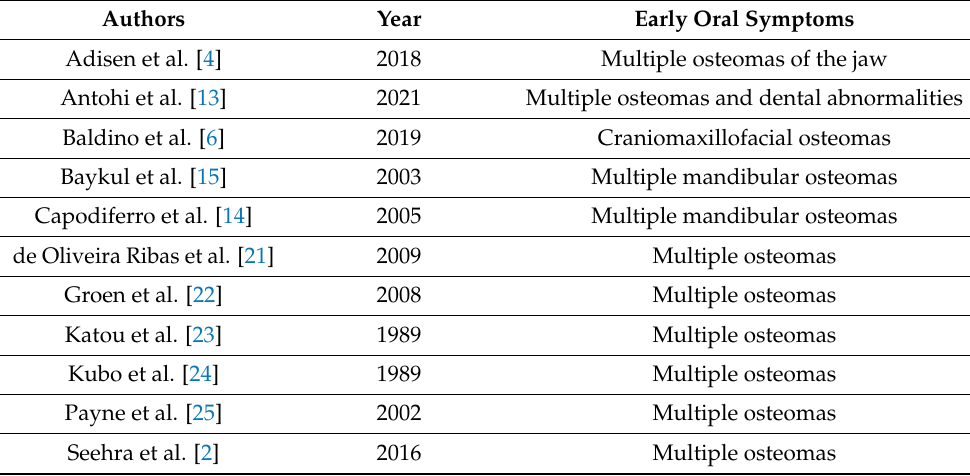
Table A1. Brief narrative summary of the suitable articles alphabetically